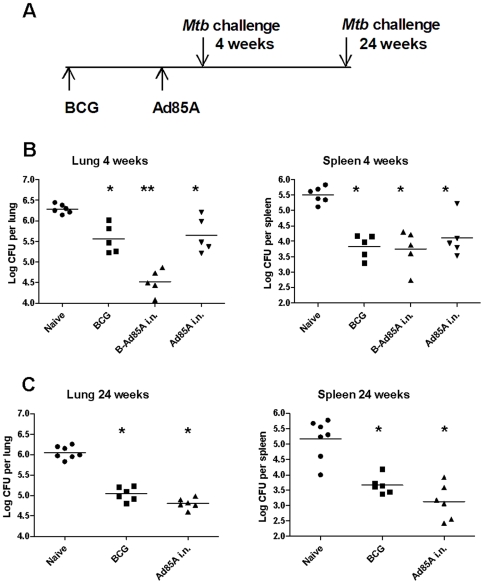
Intranasal administration of Ad85A increases protection at 4 and 24 weeks.(A) Time line of the experiment. BALB/c mice were immunized with BCG, or primed with BCG and 10 weeks later boosted intranasally with Ad85A (B-Ad85A i.n.), or immunized only with Ad85A i.n. Naïve mice were used as challenge controls. Mice were challenged with Mtb by aerosol 4 (B) or 24 (C) weeks after the boost. Deposition in the lungs was measured 24 h after challenge and was ∼200 CFU/lung. Mice were sacrificed 6 weeks later and lung and spleen CFU enumerated. Symbols show CFU counts of individual mice and the horizontal line indicates the mean. * p<0.05 versus Naïve, **p<0.05 versus BCG. Similar results were obtained in two other experiments where the lungs and spleens were harvested at 4 weeks post Mtb challenge.